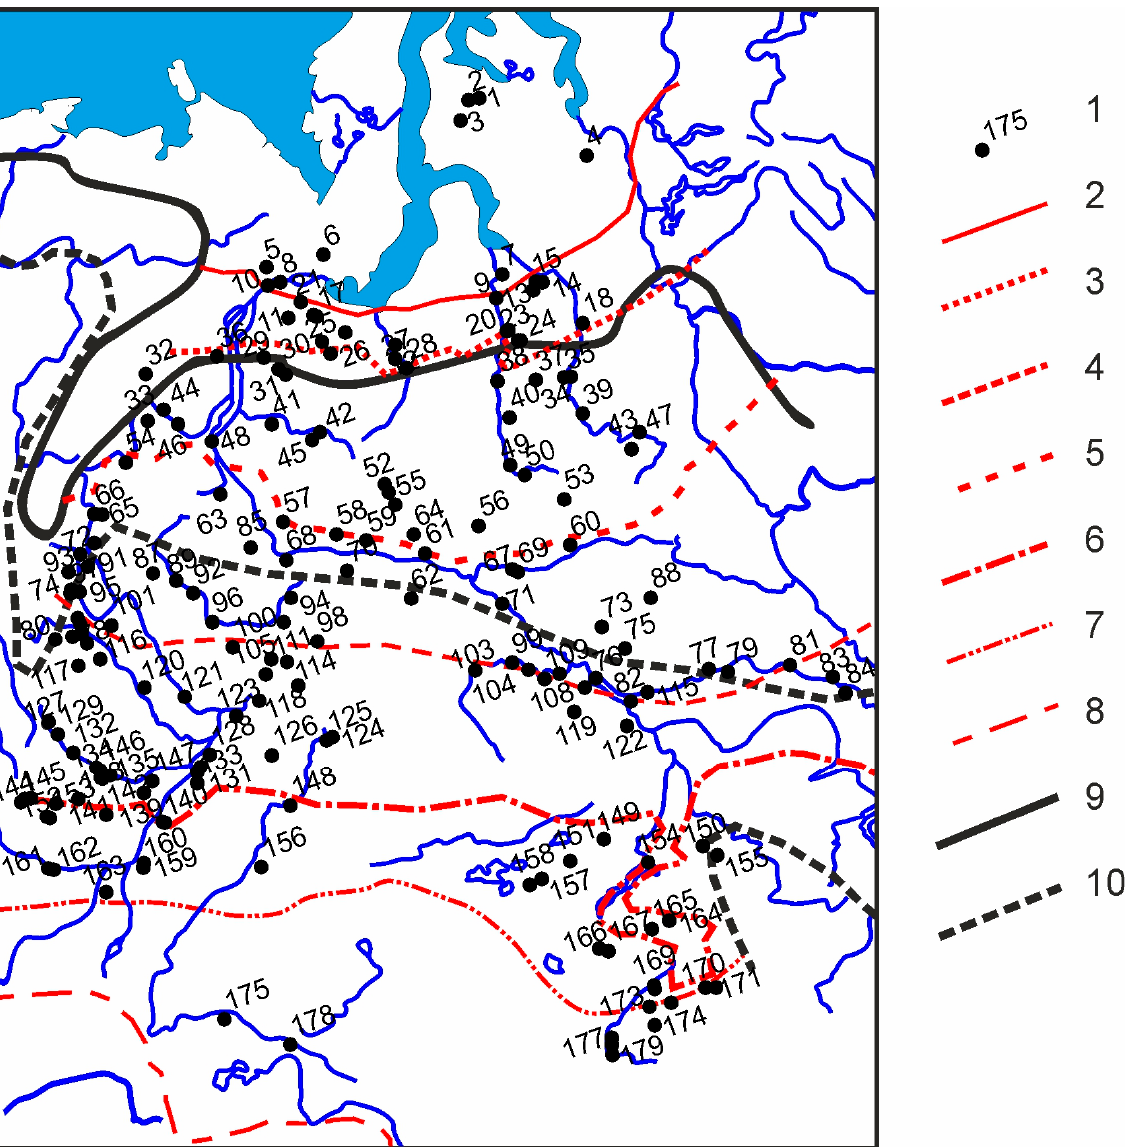
Figure 4. The distribution of hydrologic stations on the West Siberian Plain. 1—data points (Table S2). The southern boundaries of modern vegetation and permafrost zones (adapted from [21]); 2—tundra; 3—sparse forest (forest–tundra); 4—northern taiga; 5—middle taiga; 6—southern taiga; 7—forest–steppe; 8—steppe and Altai piedmont; 9—continuous permafrost; 10—discontinuous perma-